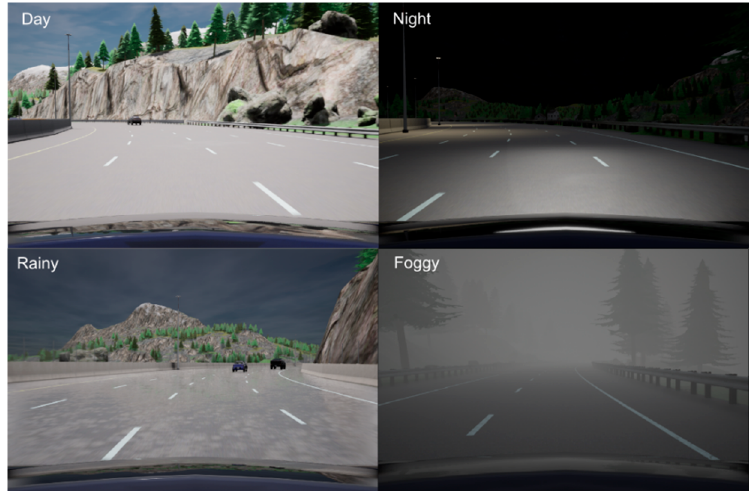
Figure 21. Example of four different weather conditions in CARLA simulator. Top left: clear daytime, top right: night drive, bottom left: overcast/rain, bottom right: foggy conditions.